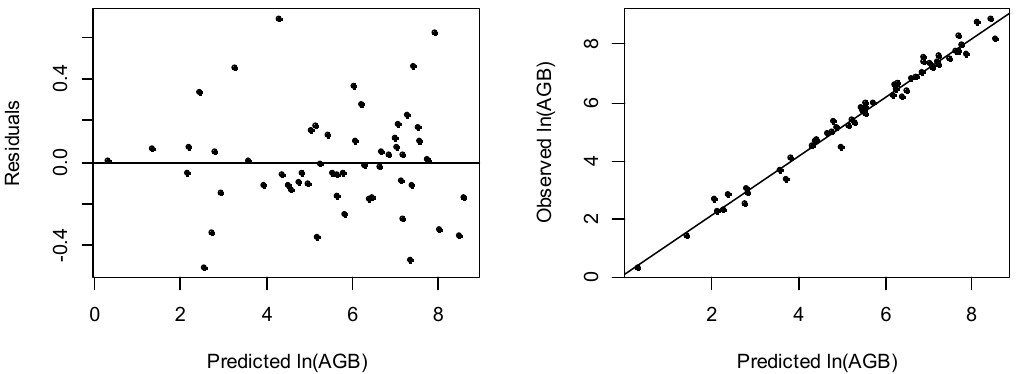
Figure 4. Residuals vs. predicted values and observed vs. predicted values of aboveground biomass (AGB). Values are predicted from Equation (5). Original units are in kilograms of dry mass.